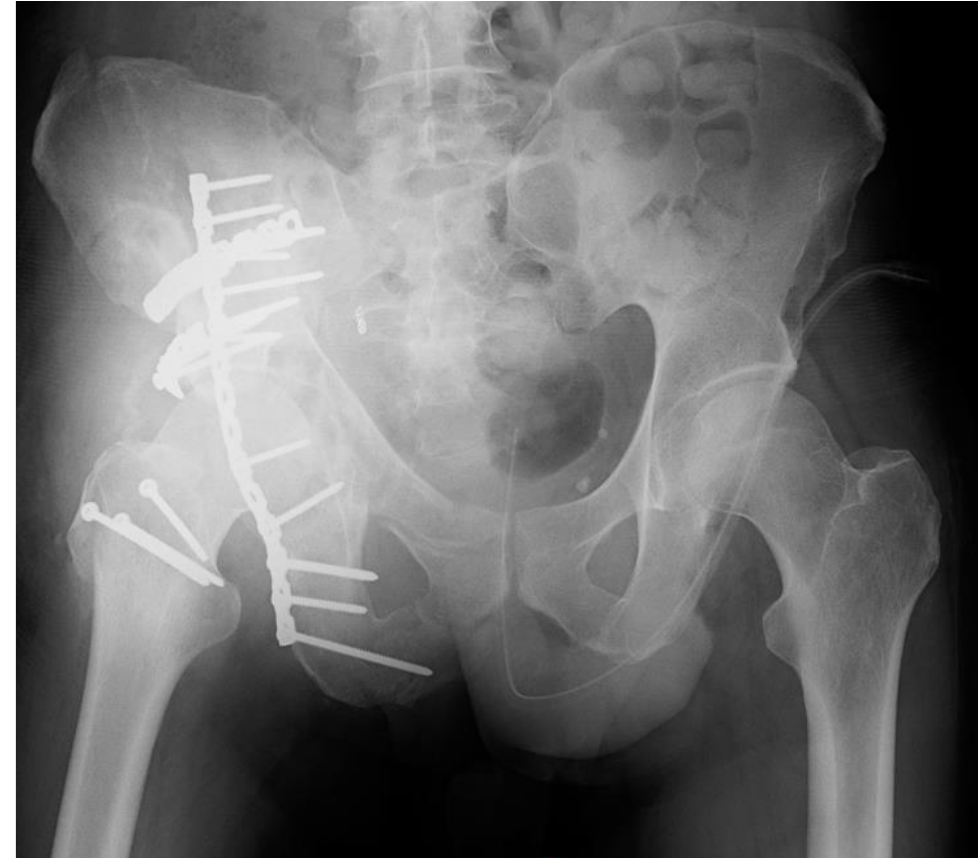
Figure 1. X-ray of the pelvis and hip when the patient came to our attention. He came to our attention six months after the treatment of the pelvic fracture with ORIF with no weight-bearing, right groin pain, a fever > 38 ◦ C, and a discharging sinus in the right peritrochanteric region next to the surgical scar of the right hip (a KocherºLangenbeck approach was used). The diagnosis of the infection was made thanks to the presence of a discharging sinus. We firstly performed clinical evaluation and blood tests with an ESR (erythrocyte sedimentation rate) and CRP (C-reactive protein) evaluation; then, we decided to perform instrumental planning with X-rays, and computed tomography (CT) scans. We observed a fracture-related infection of the right acetabulum with necrosis of the right femoral head. The patient reported previous oral antibiotic therapy with Amoxicillin (1 g) three times a day and Minocycline (100 mg) two times a day, with the lack of a noted germ. Due to the clinical, instrumental and laboratory indications, we decided to treat him for the fracture-related infection. A two-stage revision was planned using the same approach (Kocher–Langenbeck). In the surgery, we planned to perform implant removal, irrigation, and debridement; in the second surgery, we planned to complete